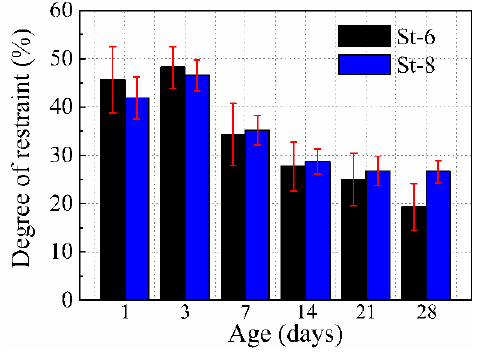
Figure 14. Average degrees of restraint at the 15, 75-c, 75-l, 75-r, 75-c, and 135 positions.